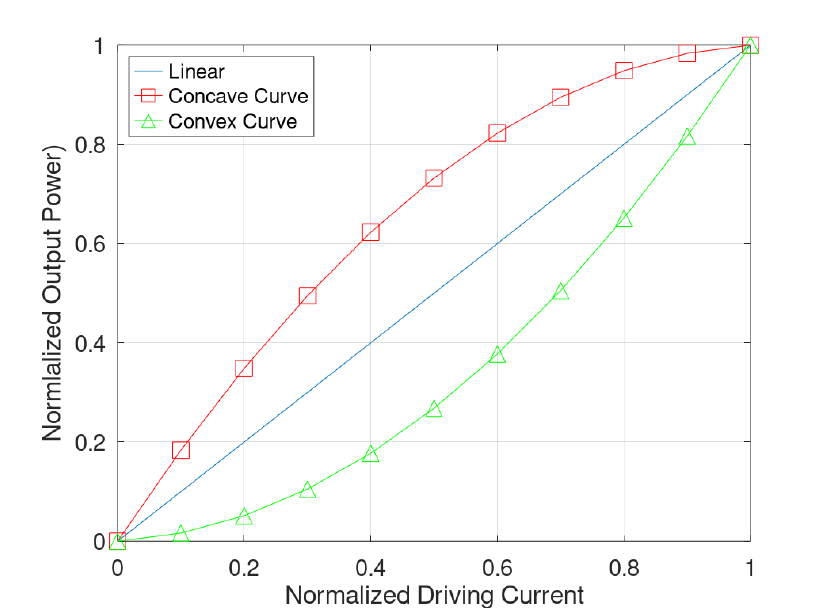
Figure 2. A comparison among concave curve with ζ = 0.732, convex curve with ζ = 0.268, and linear static transfer